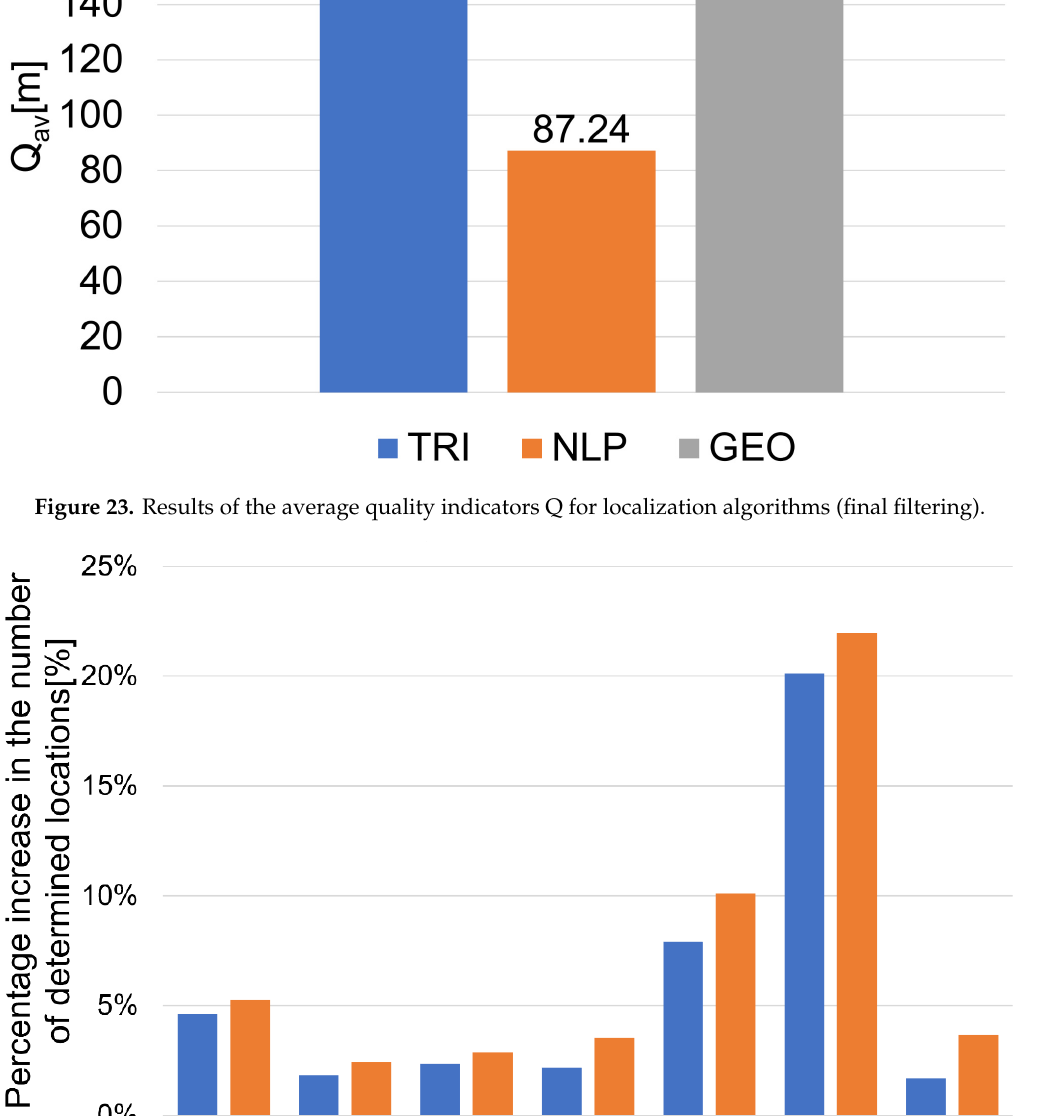
Figure 24. Percentage increase in the number of determined locations in the case of localization algorithms for trajectories 1–7.